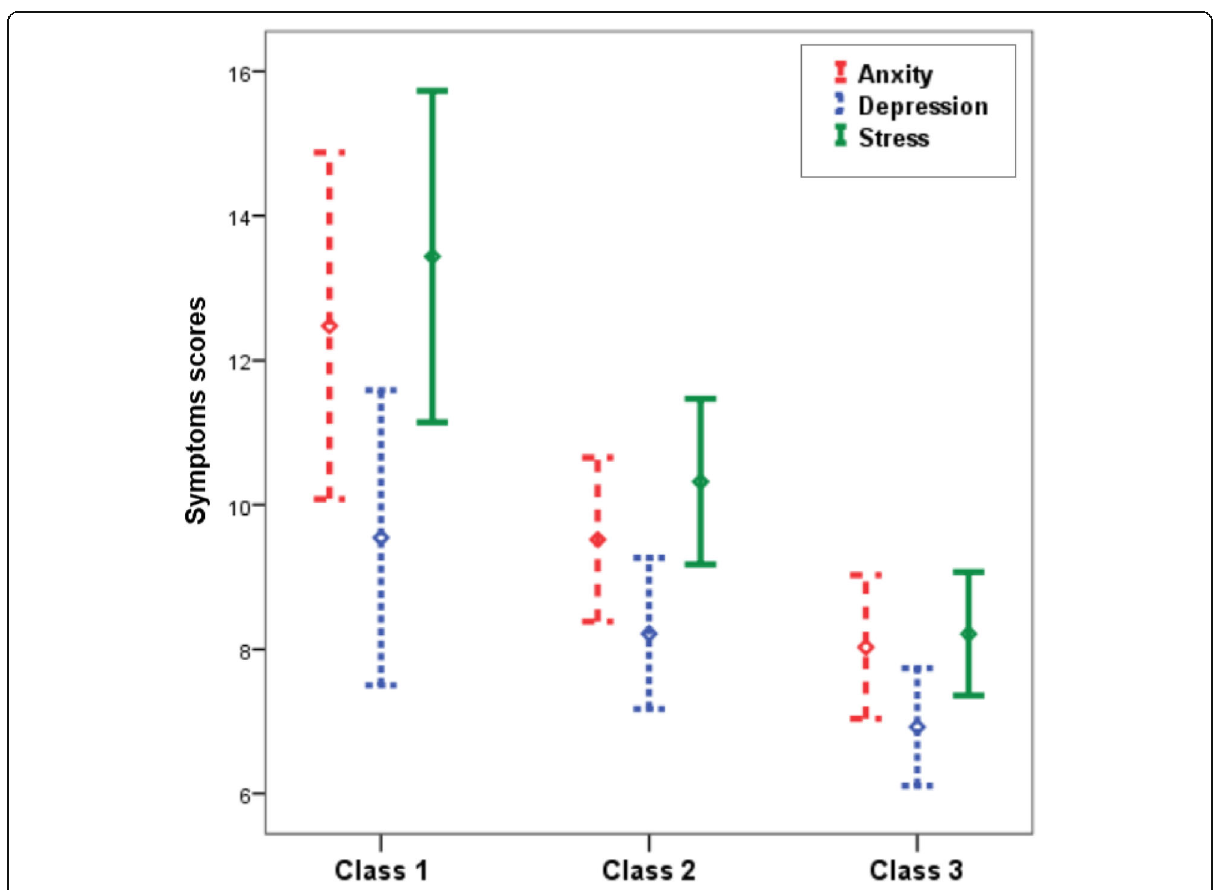
Fig. 3 Mean and 95% confidence interval of anxiety (dashed line), depression (dotted line), and stress (solid line) scores across latent class-derived patterns of MSD. (Class 1, high rate of MSDs in neck, shoulder and joints; class 2: high rate of MSDs in upper and lower back; class 3, low rate of MSDs in all